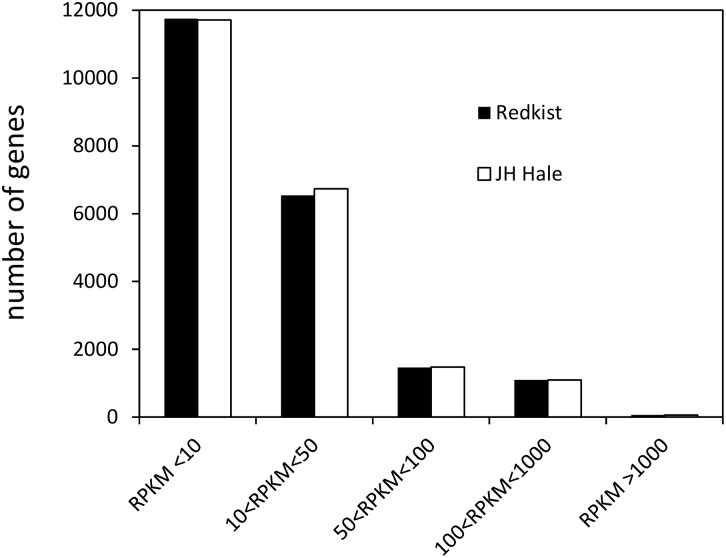
Distribution of frequency classes of gene expression levels (RPKM) after Xap inoculation on leaves of ‘JH Hale’ (susceptible) and ‘Redkist’ (resistant) peach cultivars.